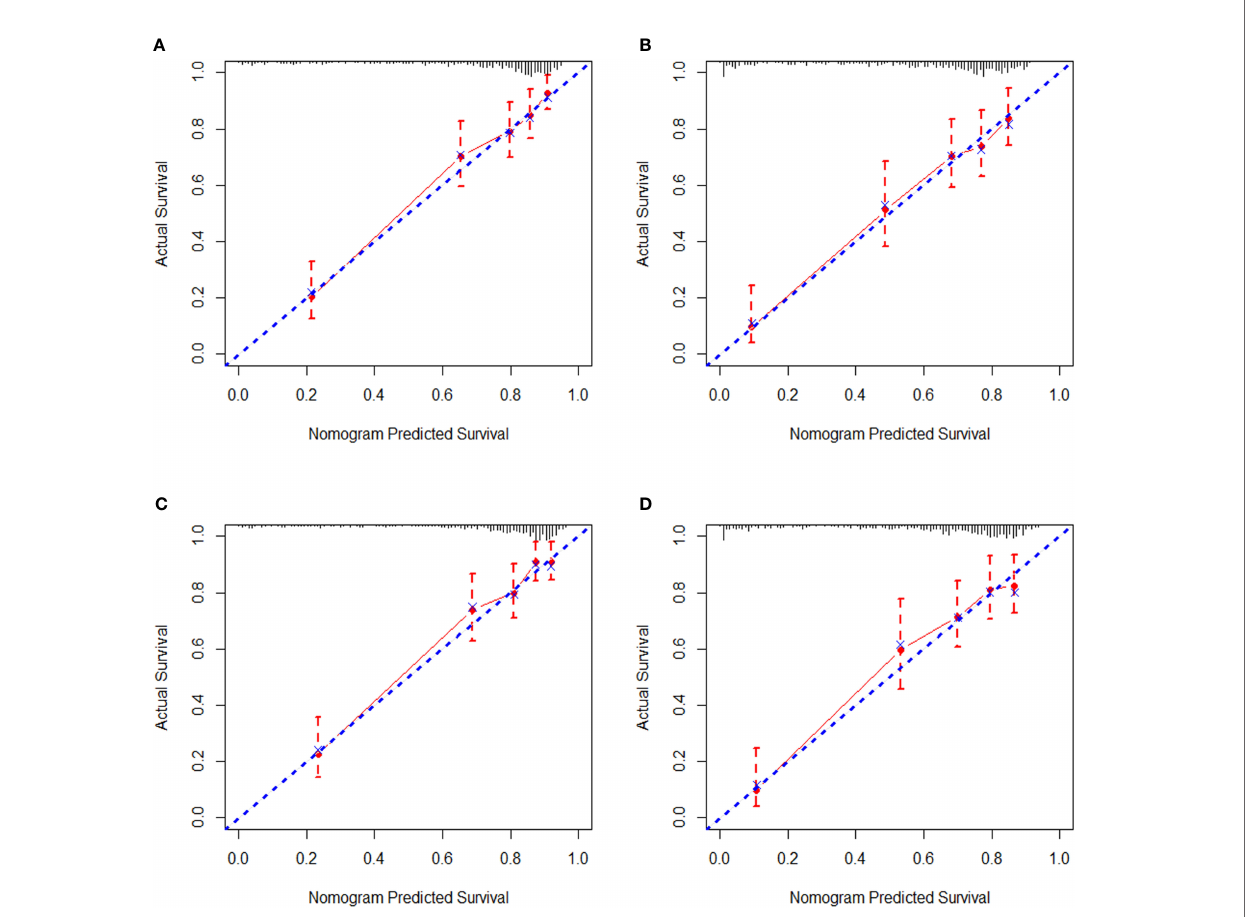
FIGURE 4 | External calibration curves in the validation cohort. (A) The 3-year and (B) 5-year overall survival (OS) nomogram calibration curves. (C) The 3-year and (D) 5-year cancer-speci fi c survival (CSS) nomogram calibration curves.